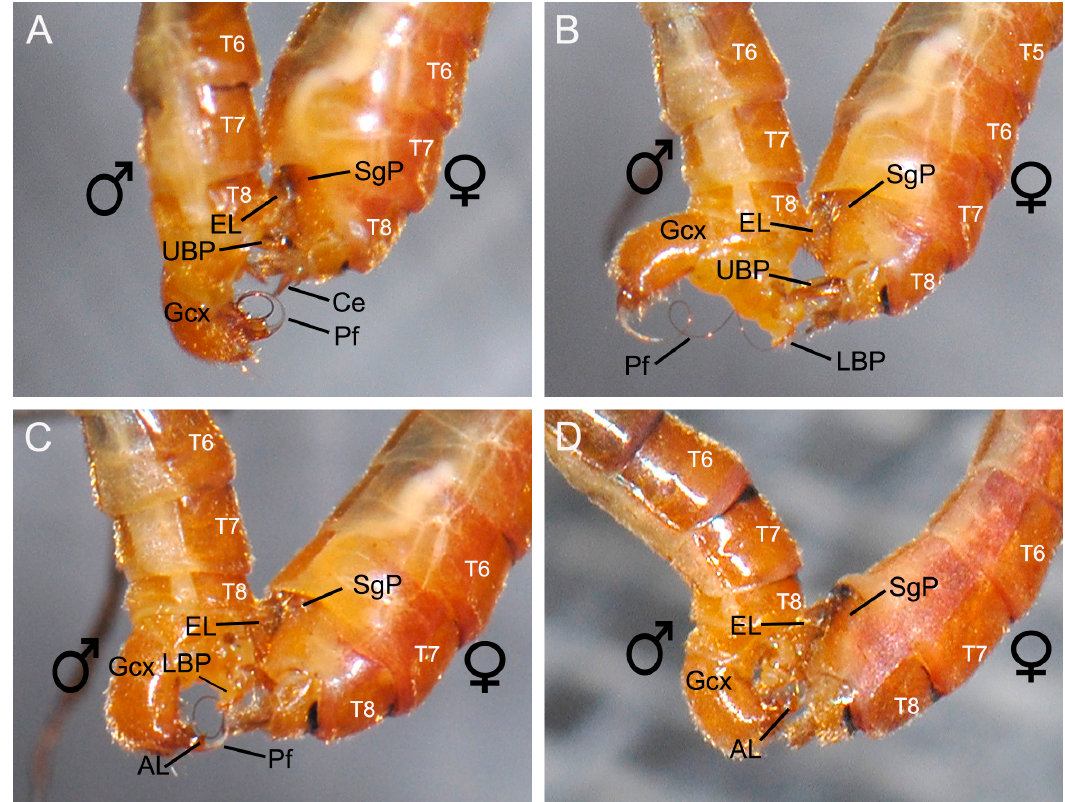
Figure 5. The dorsal end (female segments III ‐ VIII) of copulating Terrobittacus implicatus , showing the gradual insertion process of the male penisfilum. ( A ) The male firmly holds the subgenital plate of the female by his epandrial lobes and the upper branch of the proctiger extends into the female genital chamber. ( B ) The elongated penisfilum is stretched by the lower branch of the proctiger and the proctiger assists the entering of the male penisfilum into the female. ( C ) The partly inserted penisfilum. ( D ) The male penisfilum is fully inserted into the female. Abbreviations: AL, aedeagal lobe; Ce, cercus; EL, epandrial lobe; Gcx, gonocoxite; LBP, lower branch of proctiger; Pf, penisfilum; SgP, subgenital plate; UBP, upper branch of proctiger; T5 − T8, terga V − VIII.